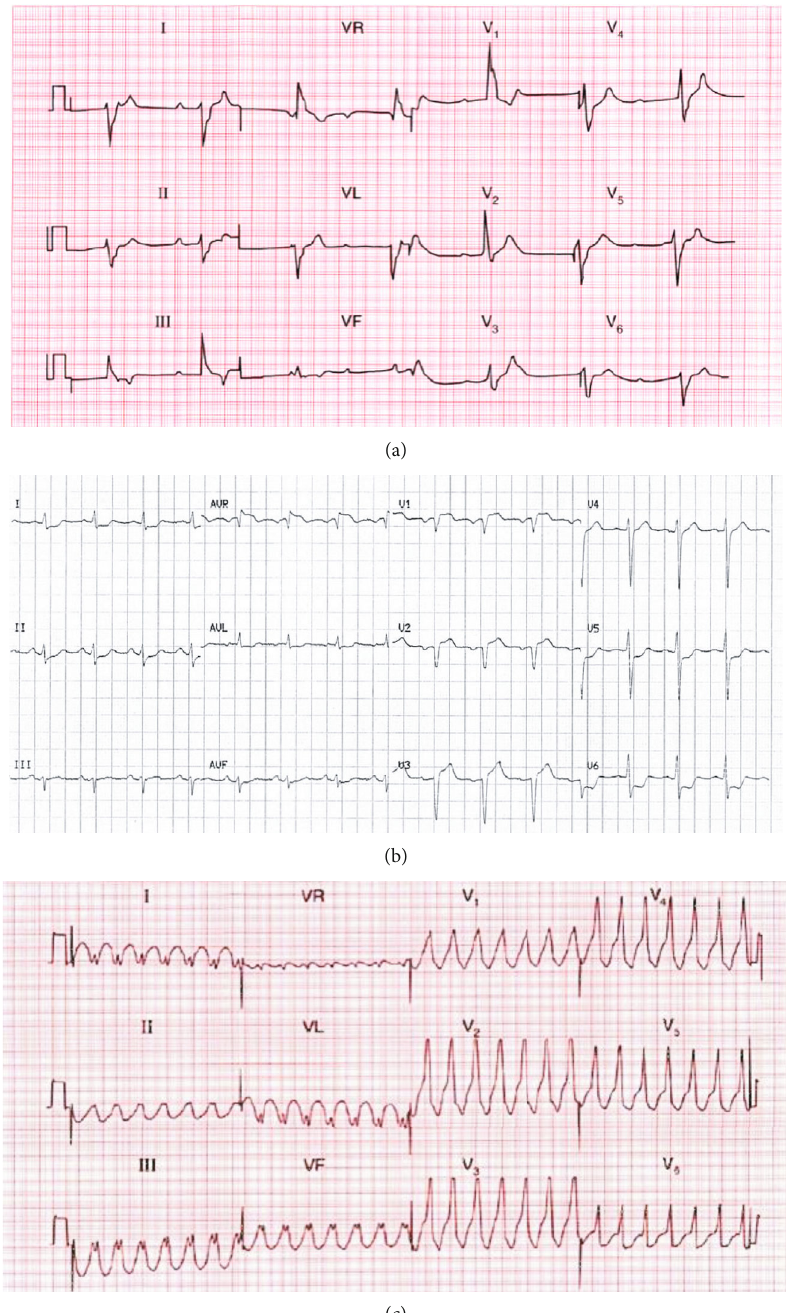
Figure 1: (a) ECG of patient 1 on day 5 ICU admission showing CHB with ventricular escape rhythm rate approximately 50bpm. (b) ECG of patient 1 on day 8 admission showing ST elevation in lead AVR and ST depression at leads 1, AVL, II, AVF, V5, and V. (c) ECG of patient 1 on day 8 admission showing ventricular tachycardia and subsequently pulseless electrical activity (not (Table 1, Supplementary data). ECG on admission (Figure 3(a)) showed sinus tachycardia at 167 bpm, normal intervals, normal axis, and absence of ischemic fi ndings.